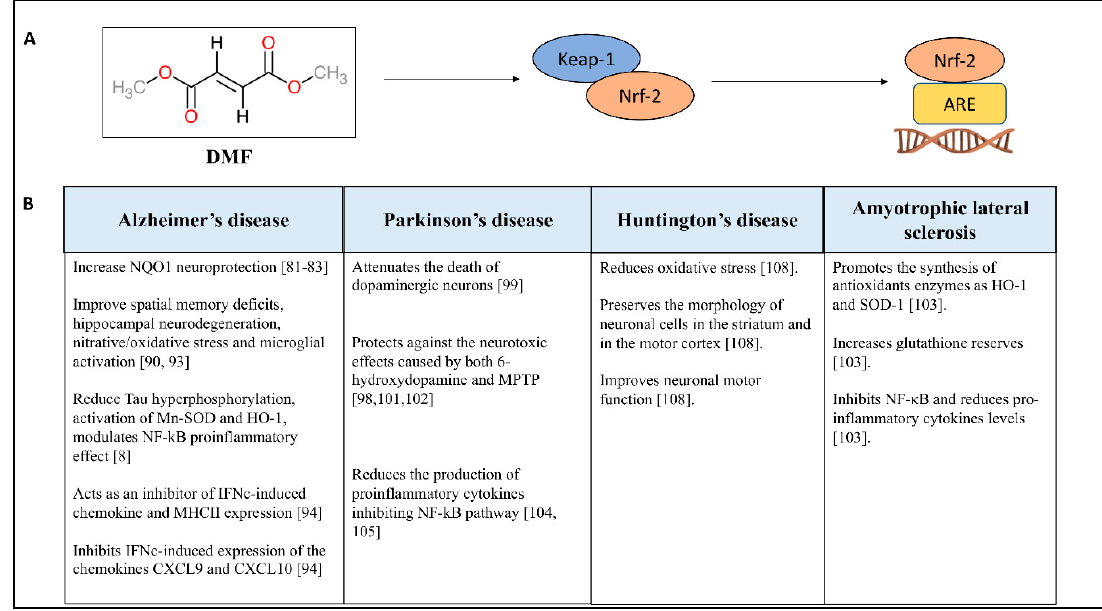
Figure 2. Properties of DMF in NDs. ( A ) shows the mechanism of action of DMF through Keap1/Nrf2/ARE pathway; ( B ) provides a table which summarizes the main effects of DMF in NDs (specifically for AD, PD, HD, ALS).